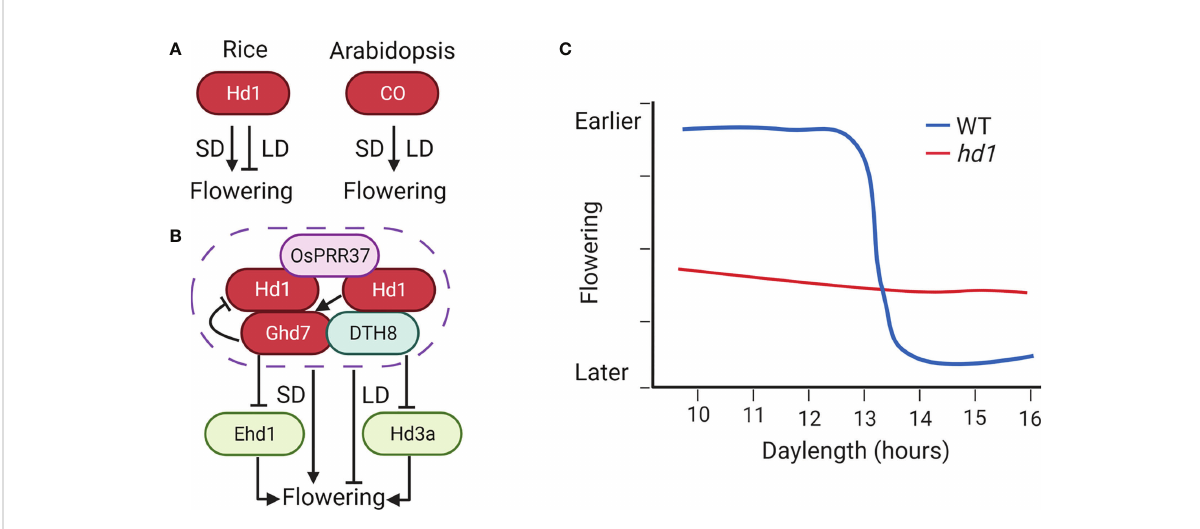
FIGURE 2 Bifunctional Hd1 and its enhancers Ghd7 , DTH8 , and OsPRR37 in rice. (A) The opposite function between Hd1 and CO under LD. (B) Three enhancers of bifunctional Hd1 . Ghd7 , DTH8 , and OsPRR37 could improve the dual function of Hd1 , thus enhancing the photosensitivity of fl owering in rice. (C) Hd1 predominantly regulates photoperiodic response in rice. Arrows represent positive regulation, inhibitors represent negative regulation, and graphical overlap represents protein physical